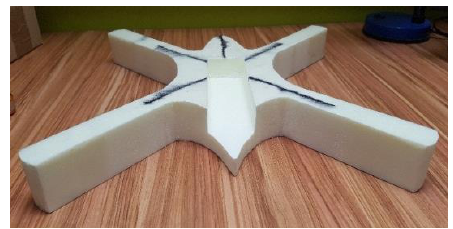
Figure 1. Ultralight frame of own design .